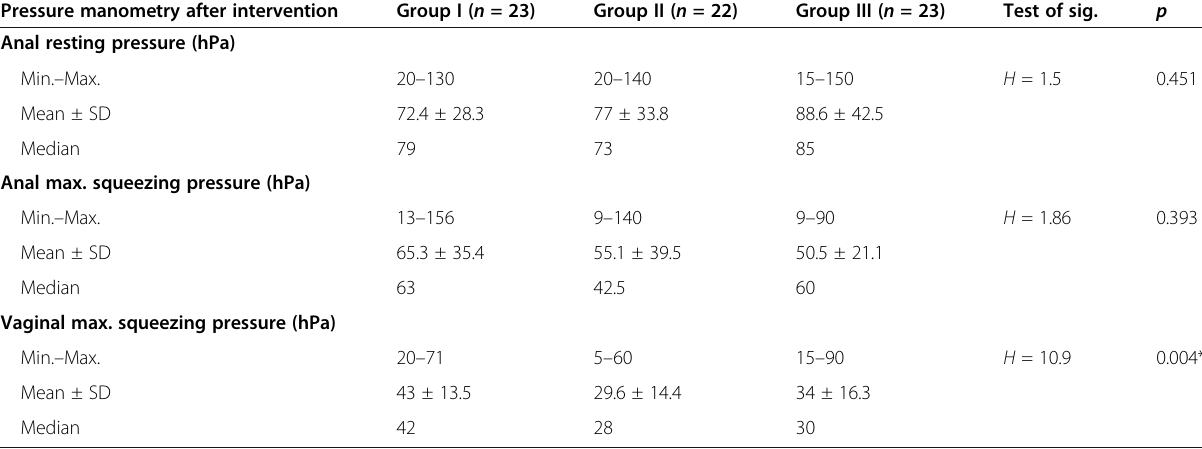
Table 5 Comparison of the pressure manometric assessment in the three groups after the intervention Pressure manometry after intervention Group I ( n = 23) Group II ( n = 22) Group III ( n = 23) Test of sig.